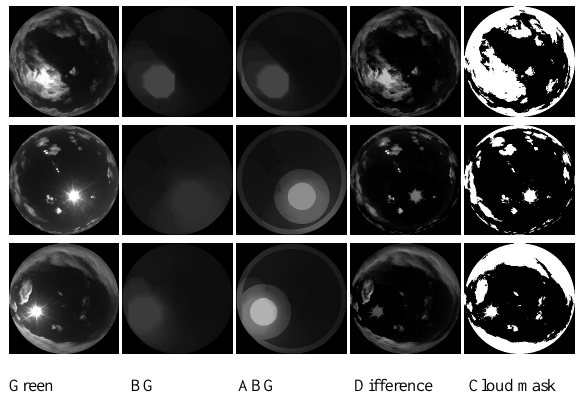
Figure 7. Modified background subtraction using the green chan- nel.